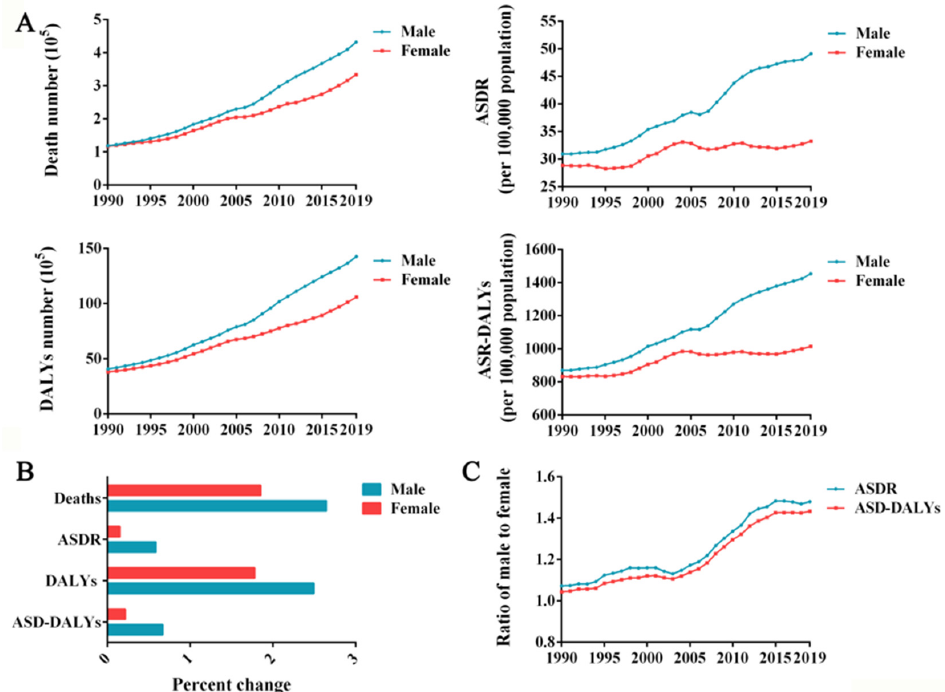
Figure 2. Burden of deaths and DALYs due to high BMI in both sexes in China. ( A ) Deaths, ASDRs, DALYs and ASR-DALYs due to high BMI in men and women in China from 1990 to 2019. ( B ) The percentage changes in deaths, ASDRs, DALYs and ASR-DALYs due to high BMI in men and women between 1990 and 2019. ( C ) Male-to-female ratios of ASDRs and ASR-DALYs due to high BMI in men and women from 1990 to 2019.